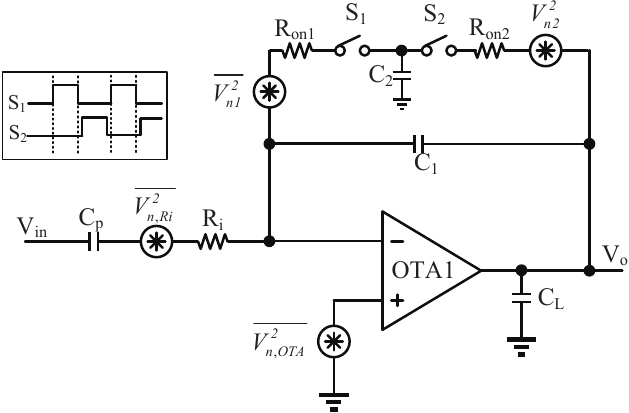
Figure 4. Noise model of the charge